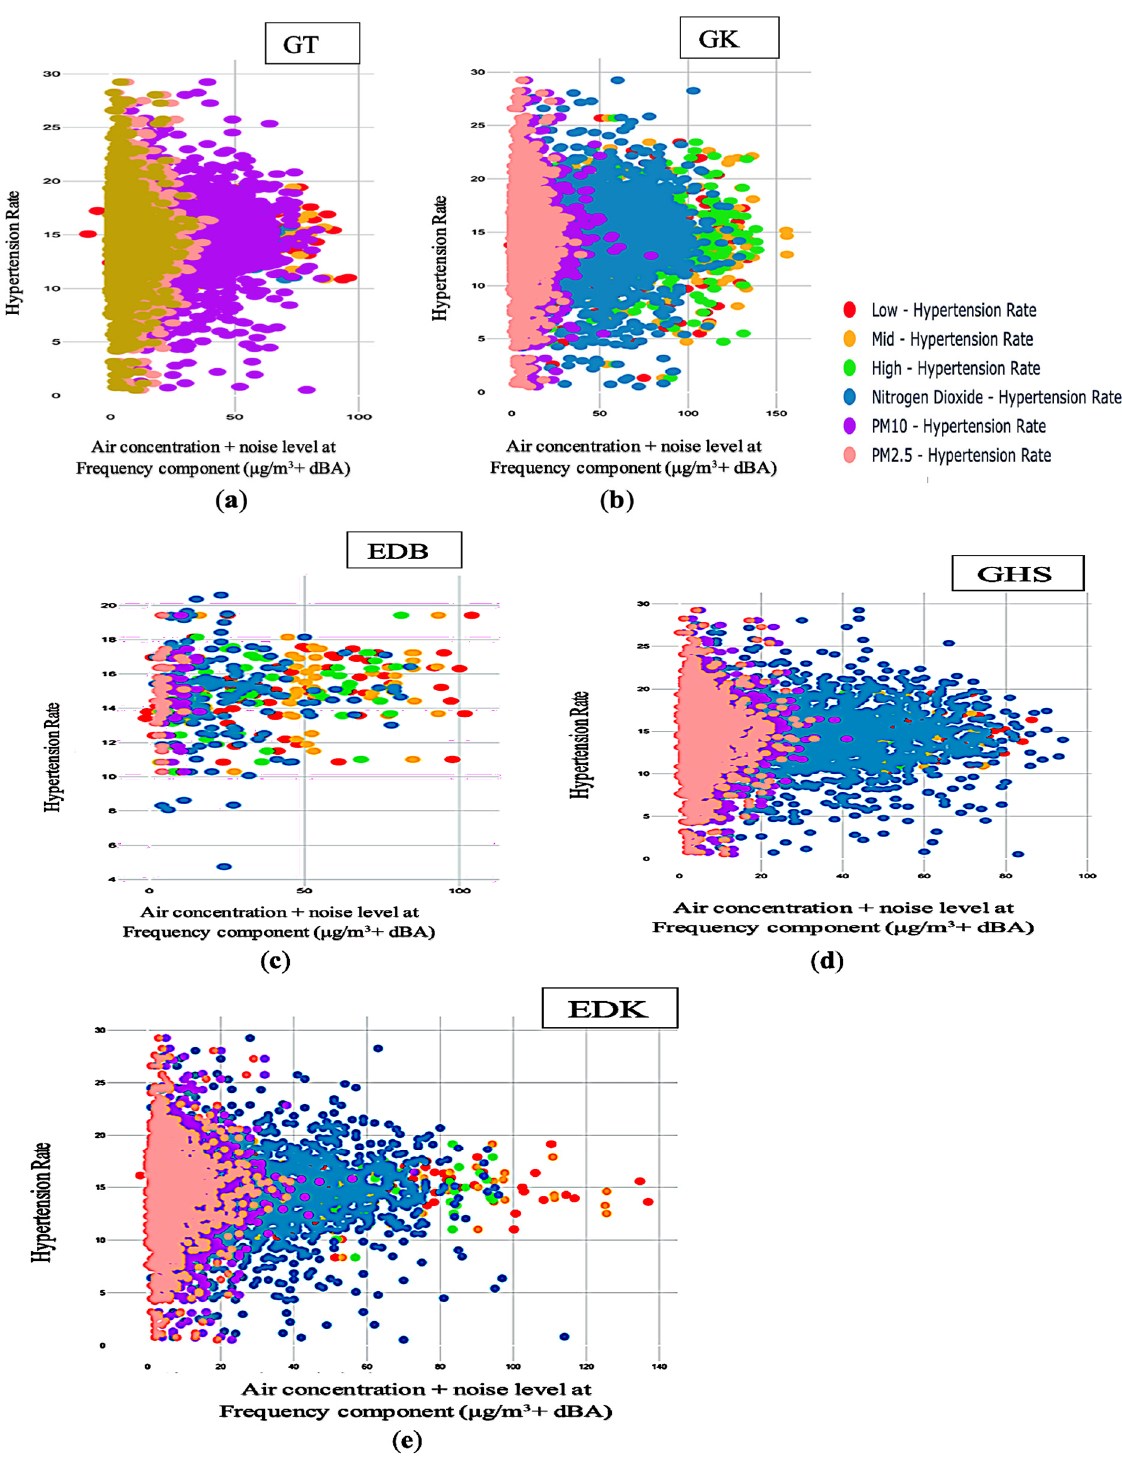
Figure 2. Relationship between joint air concentration and noise level at different frequency com- ponent range and hypertension rate at the five monitoring sites: ( a ) Joint air-noise pollution (dBA)/( μ g/m 3 ) with hypertension rate at GT; ( b ) Joint air-noise pollution (dBA)/( μ g/m 3 ) with hypertension rate at GK; ( c ) Joint air-noise pollution (dBA)/( μ g/m 3 ) with hypertension rate at EDB; ( d ) Joint air- noise pollution (dBA)/( μ g/m 3 ) with hypertension rate at GHS; ( e ) Joint air-noise pollution (Lden)/( μ g/m 3 ) hypertension rate at EDK.